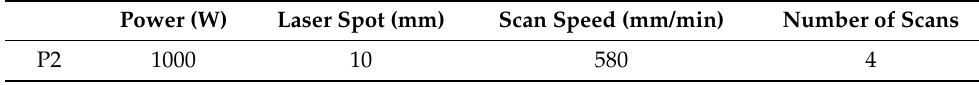
Table 3. Summary of the new conditions for the